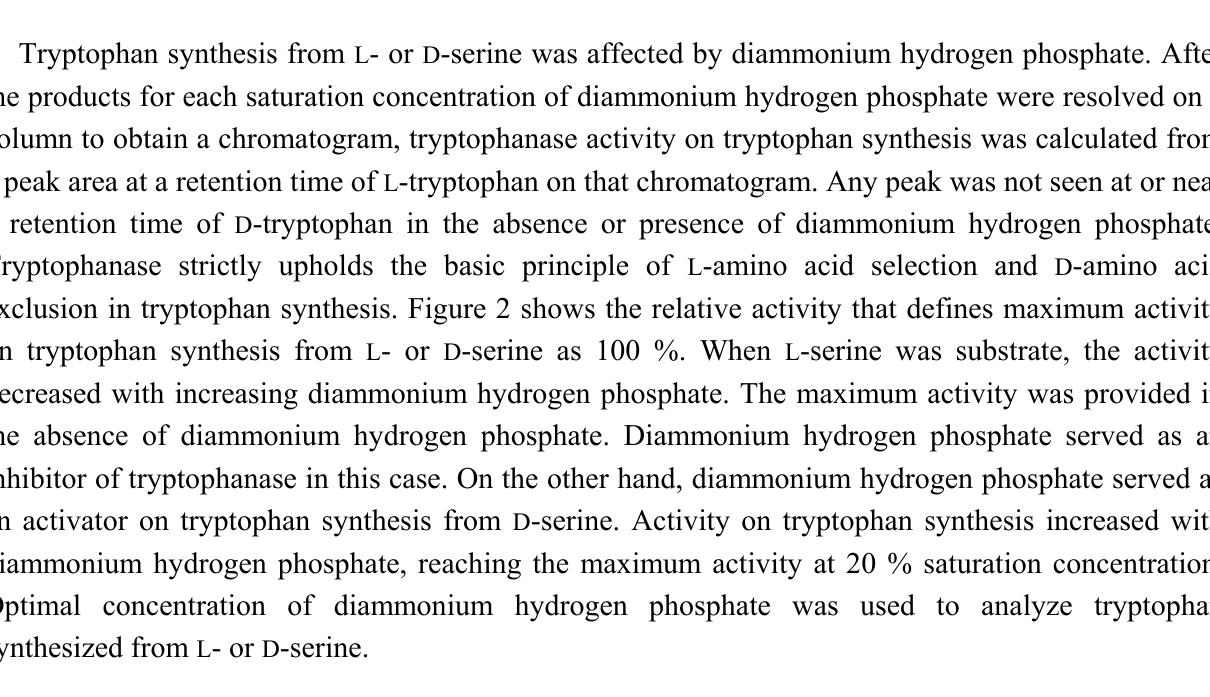
Figure 2. Tryptophan synthesis from L - or D -serine against diammonium hydrogen phosphate saturation concentration. ○ : L -serine, ● : D